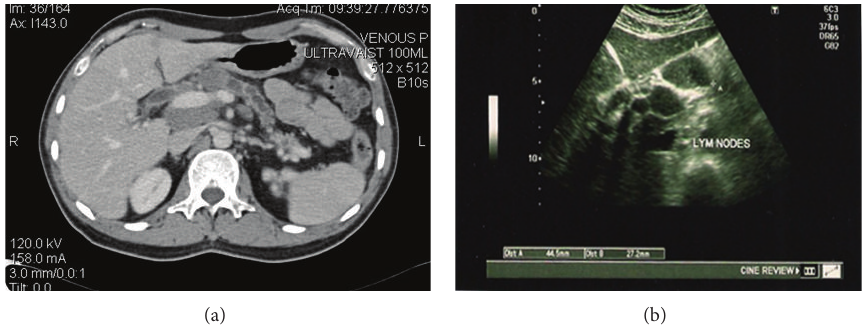
Figure 4: 18 months after initial presentation. (a) CT showing persistent enlarged peripancreatic lymph nodes, pancreatic atrophy, and dilatation of pancreatic duct. (b) Ultrasound abdomen showing enlarged peripancreatic lymph